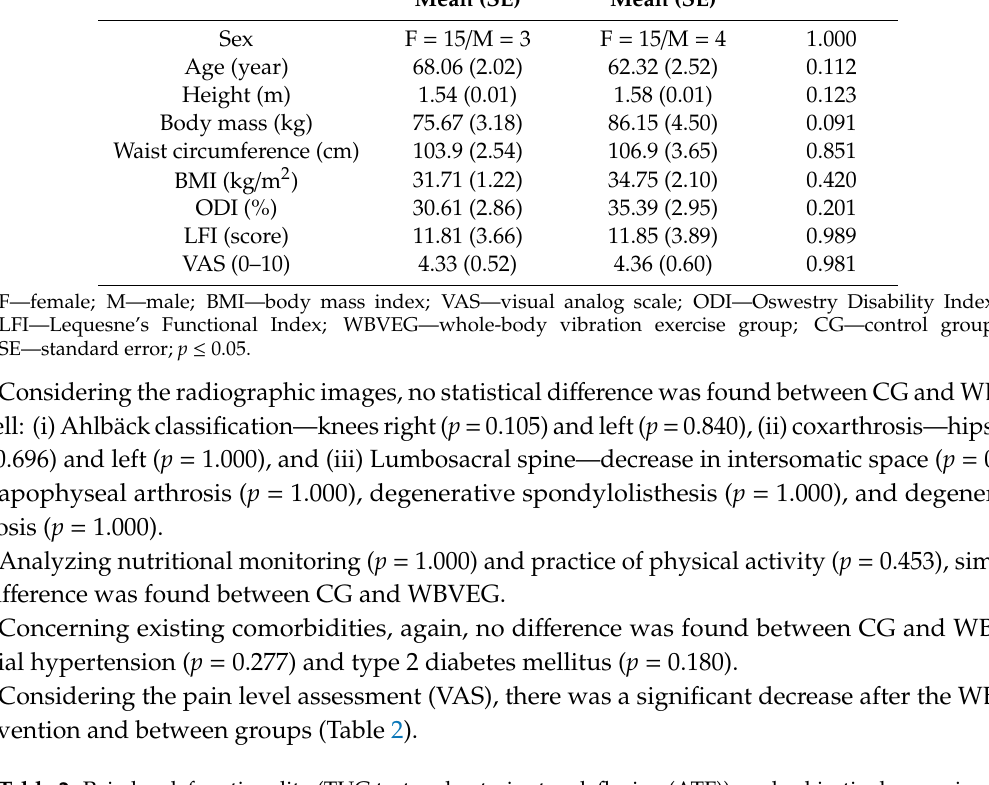
Table 1. Baseline characteristics of the knee osteoarthritis individuals of WBVEG and CG. CG ( n = 18) WBVEG ( n = 19) p -Value Mean (SE) Mean (SE) Sex F = 15 / M = 3 F = 15 / M = 4 1.000 Age (year) 68.06 (2.02) 62.32 (2.52) 0.112